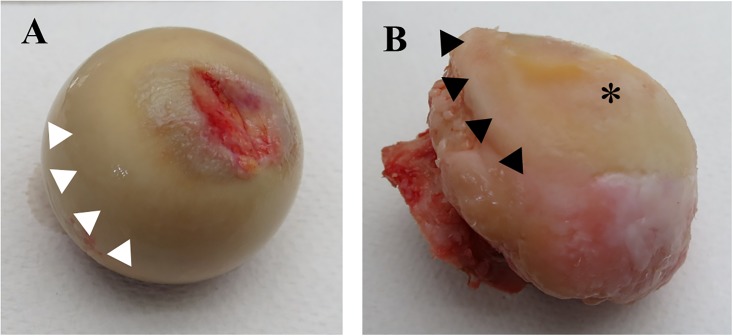
Femoral head of #NOF (fracture of neck of femur: non-OA) and OA.(A) A femoral head of #NOF. (B) A femoral head of a typical secondary OA. The articular cartilage pieces were obtained from the middle to deep layer of the non-weight bearing, macroscopically intact area from #NOF femoral head (white arrow heads), and the surface layer (black arrow heads) surrounding the weight-bearing, eburnated area (*) from OA femoral heads, respectively.